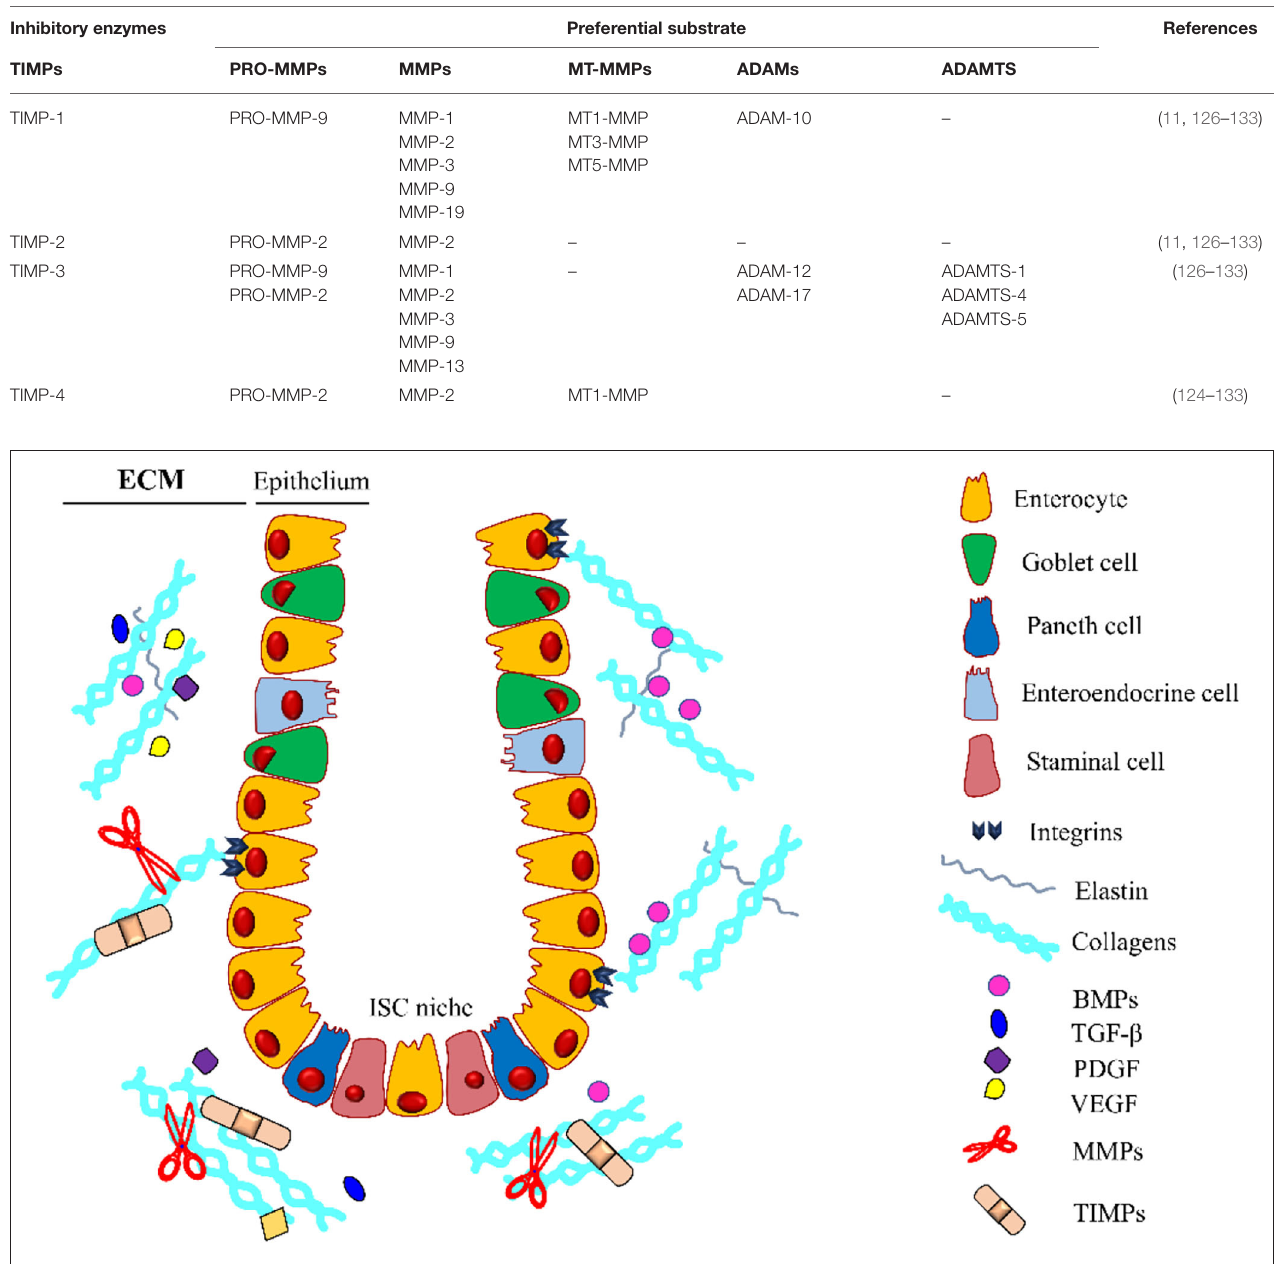
FIGURE 3 | Intestinal crypt microenvironment. Schematic representation of an intestinal crypt with the cells and the molecules involved in its homeostasis. At the base of the invagination, there is the ISC niche, essential for supplying the staminal cell pool involved in the physiological self-renewal of the epithelium. Growth factors (GFs) are entrapped in the extracellular matrix (ECM), which is constantly remodeled by the coordinated activity of ECM-producing cells, metalloproteinases (MMPs), and tissue inhibitors of metalloproteinases (TIMPs). Along the crypt, there is a gradient for some GFs (i.e., BMPs) regulating the differentiation and proliferation of the intestinal stem cells (ISCs). BMPs, Bone Morphogenetic Proteins; TGF- β , Transforming Growth Factor- β ; PDGF, Platelet-Derived Growth Factor; VEGF, Vascular Endothelial Growth Factor. The legend indicates the crypt